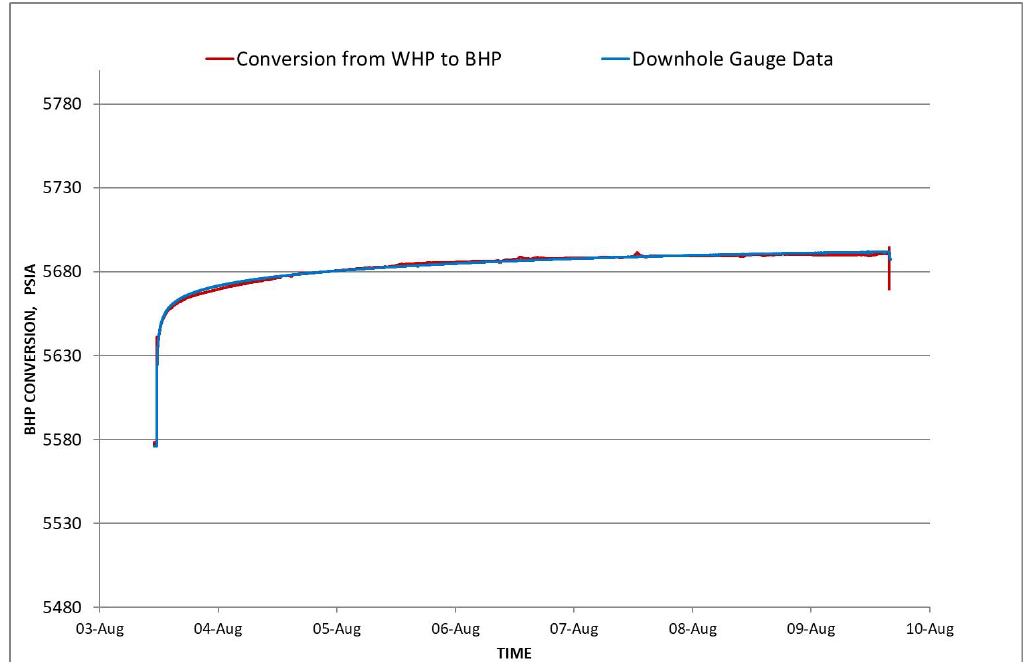
Figure 10—BHP conversion vs. downhole gauge measurement after thermal decay model